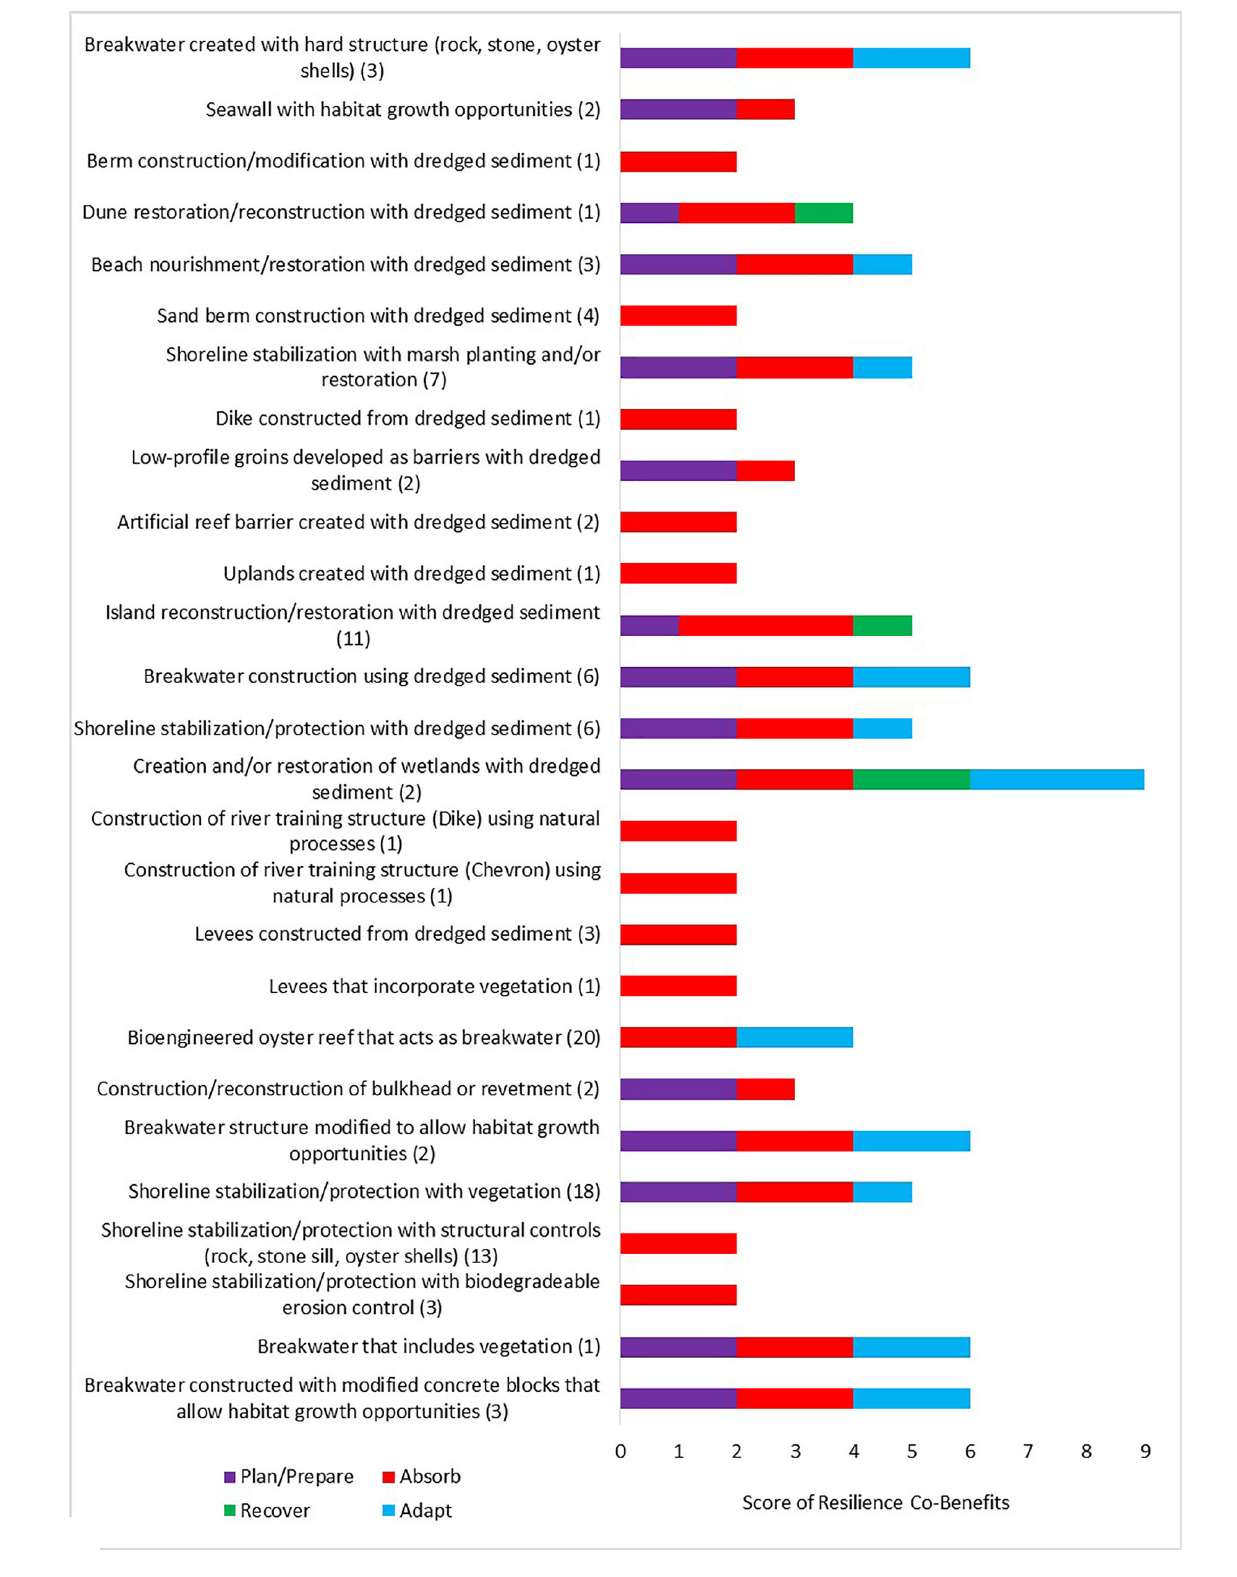
Frontiers in Ecology and Evolution |